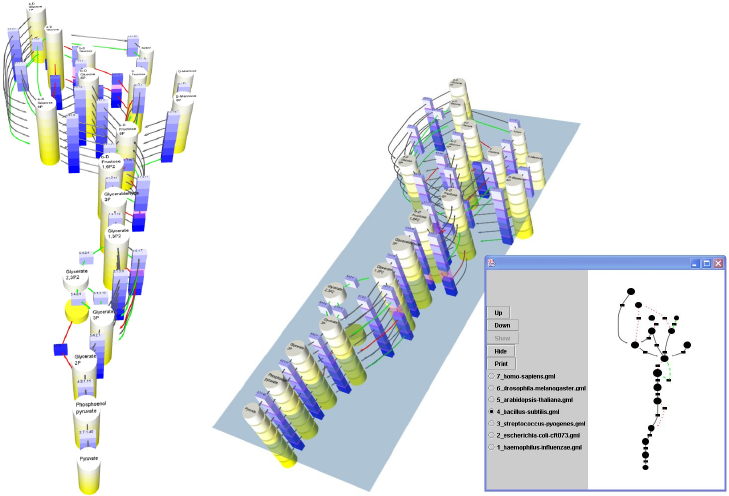
Fig. 7. WilmaScope screenshots showing perspective projection and cross-section viewer for interactive